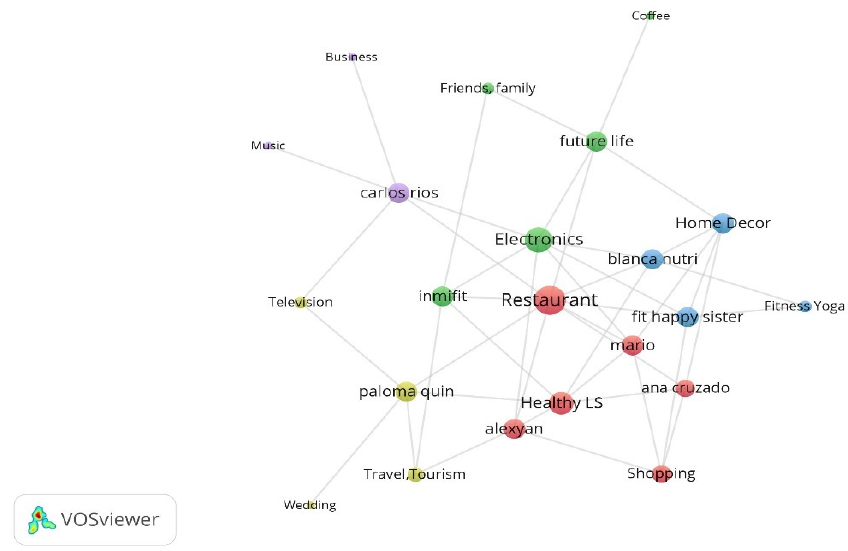
Figure 4. Concentration of the influencers’ interests.